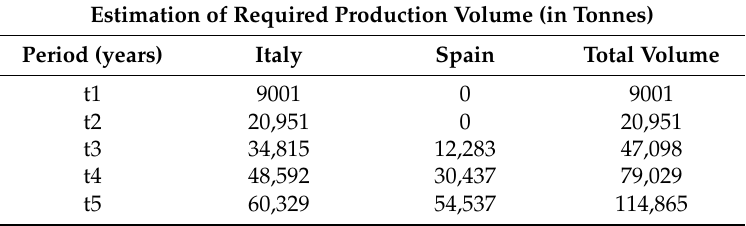
Figure 2. Diffusion curves for the five target countries. *: 1 refers to 100% diffusion whereas 0 means no diffusion at all. Table 3. Waterfall internationalization strategy and required production